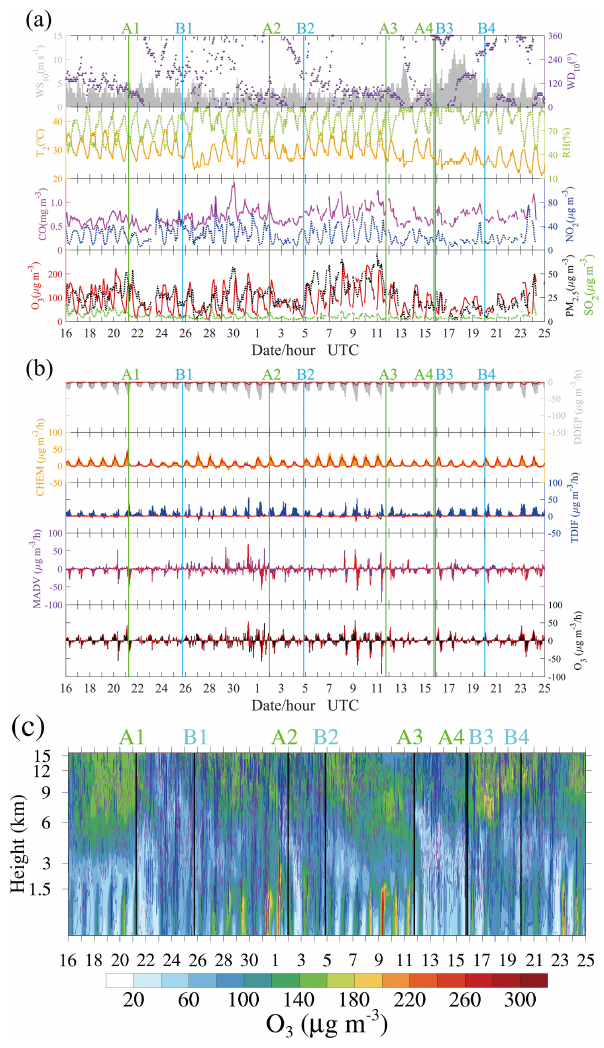
Figure 10. Same as Fig. 6a–c but for Hefei.